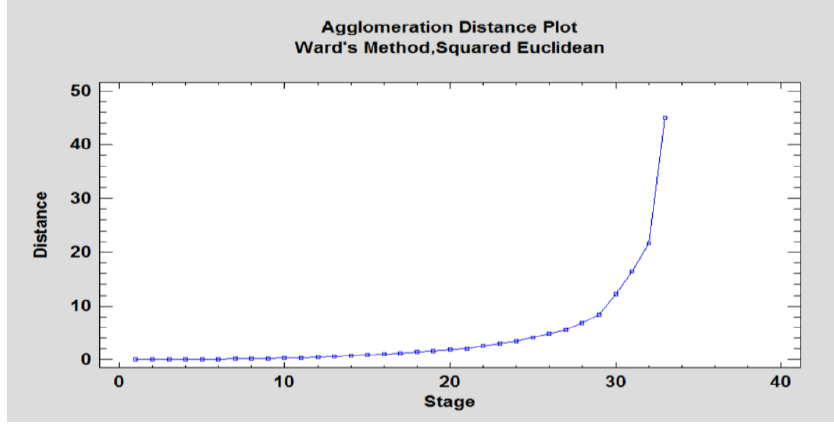
Figure 2. Dendrogram of distribution